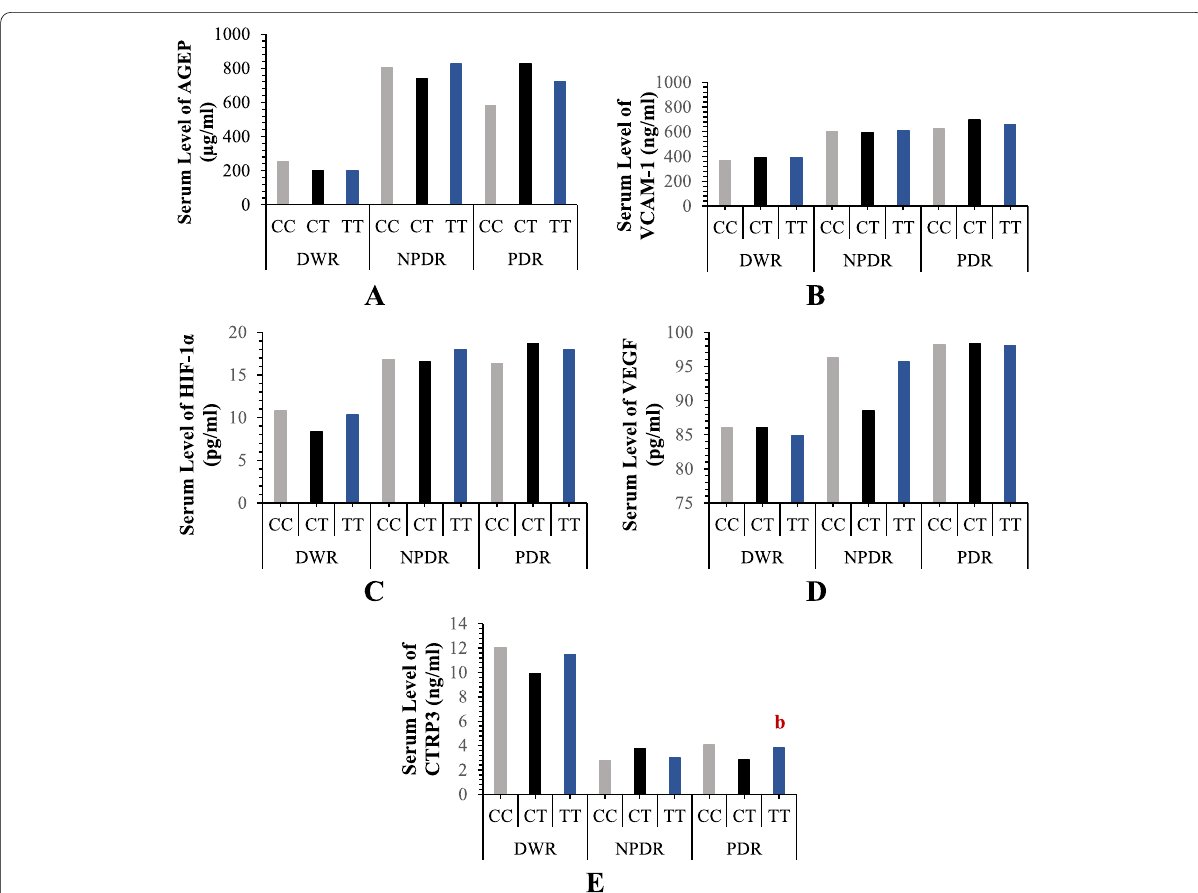
Fig. 3 The relationship of the serum levels of A AGEP, B VCAM, C HIF-1α, D VEGF, and E CTRP3 with the genotypes of VEGF rs3025039 in diabetic patients. Results are expressed as a median. a: significant compared to CC genotype while b: significant compared to CT genotype. P < 0.05 was considered